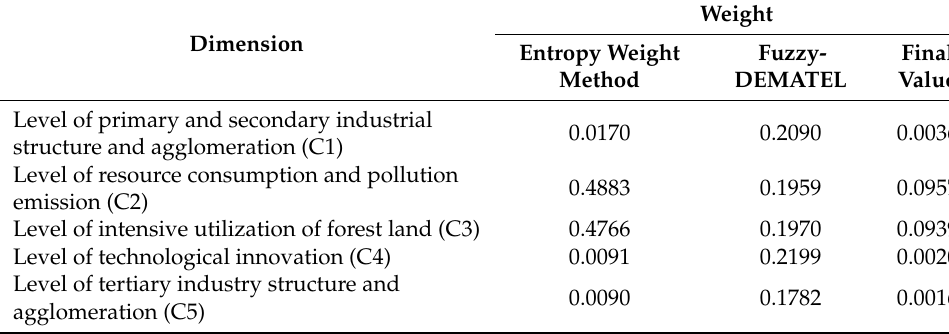
Table 4. The weights of the main factors of forestry